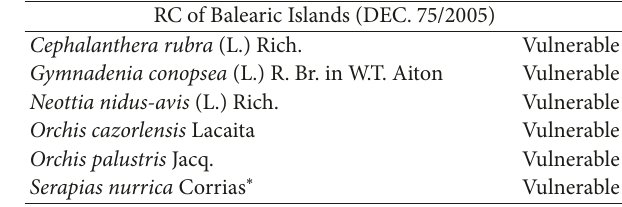
Table 6: Species included in the regional catalogue (RC) of Balearic Islands (DEC. 65/1995).